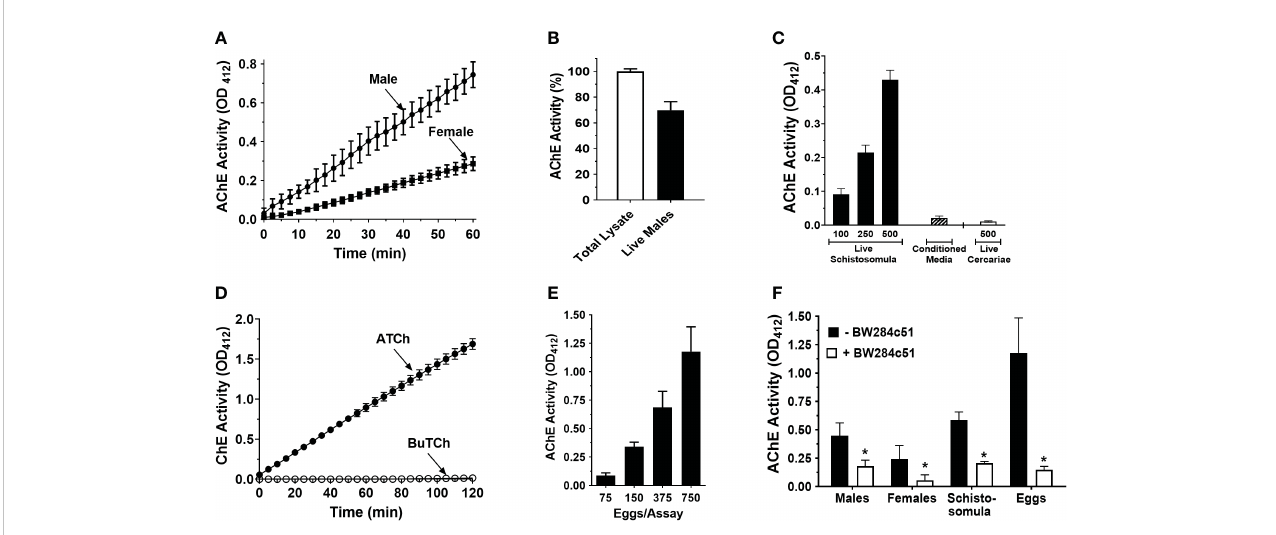
FIGURE 1 Acetylcholinesterase (AChE) activity (mean OD 412 ± SD) in live S. mansoni parasites. (A) Acetylcholinesterase activity in individual live male (circles, n>10) or female parasites (squares, n>10). Male parasites display signi fi cantly higher surface AChE than females (two-way ANOVA, p<0.0001). (B) Surface AChE activity of individual live male parasites (at 60 min, black bar) compared to total AChE activity recorded in lysates of individual male parasites (white bar, set at 100%). (C) AChE activity in groups of live, 7-day-old cultured schistosomula (black bars) or in 24 h conditioned media (from 500 cultured schistosomula, hatched bar) or in groups of 500 cercariae (white bar), at 60 min (n ≥ 3), (D) Cholinesterase (ChE) activity (mean OD 412 ± SD) displayed by live schistosomula (groups of 1000, n=4) in the presence of acetylthiocholine (ATCh, 2.5 mM, closed circles) or butyrylthiocholine (BuTCh, 2.5 mM, open circles); no cholinesterase activity is detected when BuTCh is included as substrate. (E) AChE activity in groups of freshly recovered liver eggs at 60 min, (n>5). (F) Surface AChE activity of different schistosome life stages at 60 min, (1 male, 1 female, 500 schistosomula, or 750 eggs per assay, n ≥ 4) in the presence (white bars) or absence (black bars) of the acetylcholinesterase inhibitor BW284c51 (100 µM fi nal concentration; * t test,